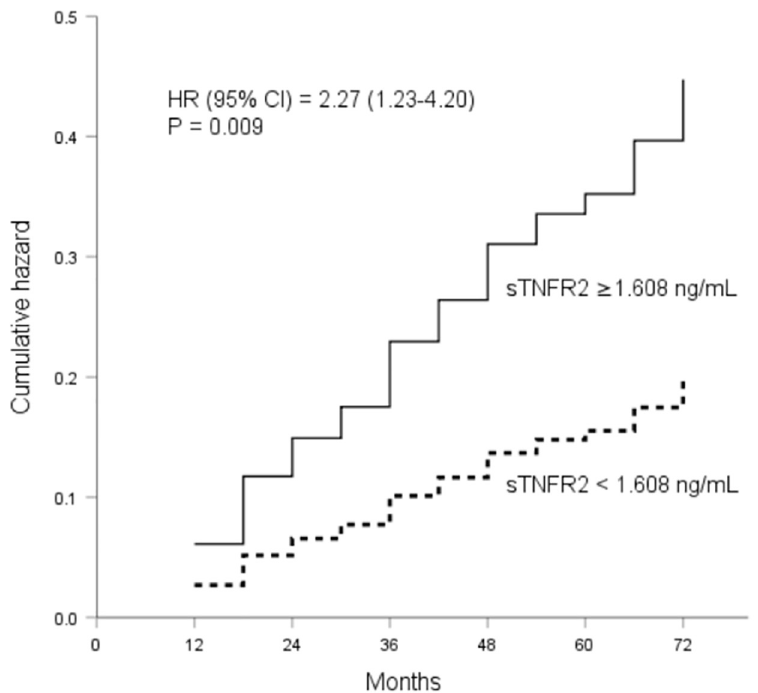
Fig 3. Cumulative hazard curves for renal events (a composite of a > 30% reduction of the estimated glomerular filtration rate and/or the progression of albuminuria stages) in patients with type 2 diabetes based on the